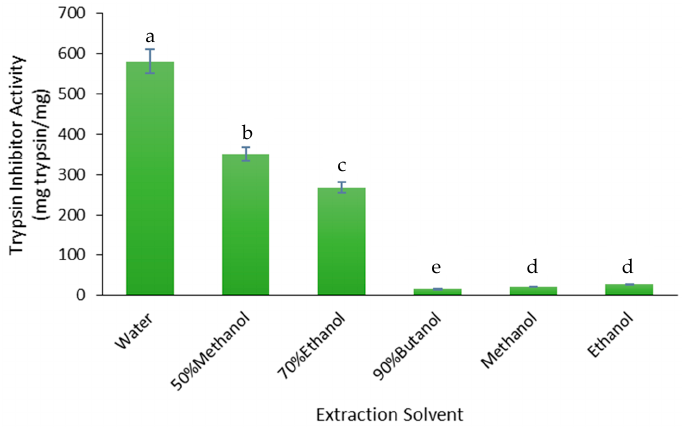
Figure 2. Effect of solvent on the trypsin inhibitor activity (TIA) of the FD crude extracts. The values are the means ± SD of three replicate extractions for each solvent. Columns not sharing the same letter are significantly different at p < 0.05.